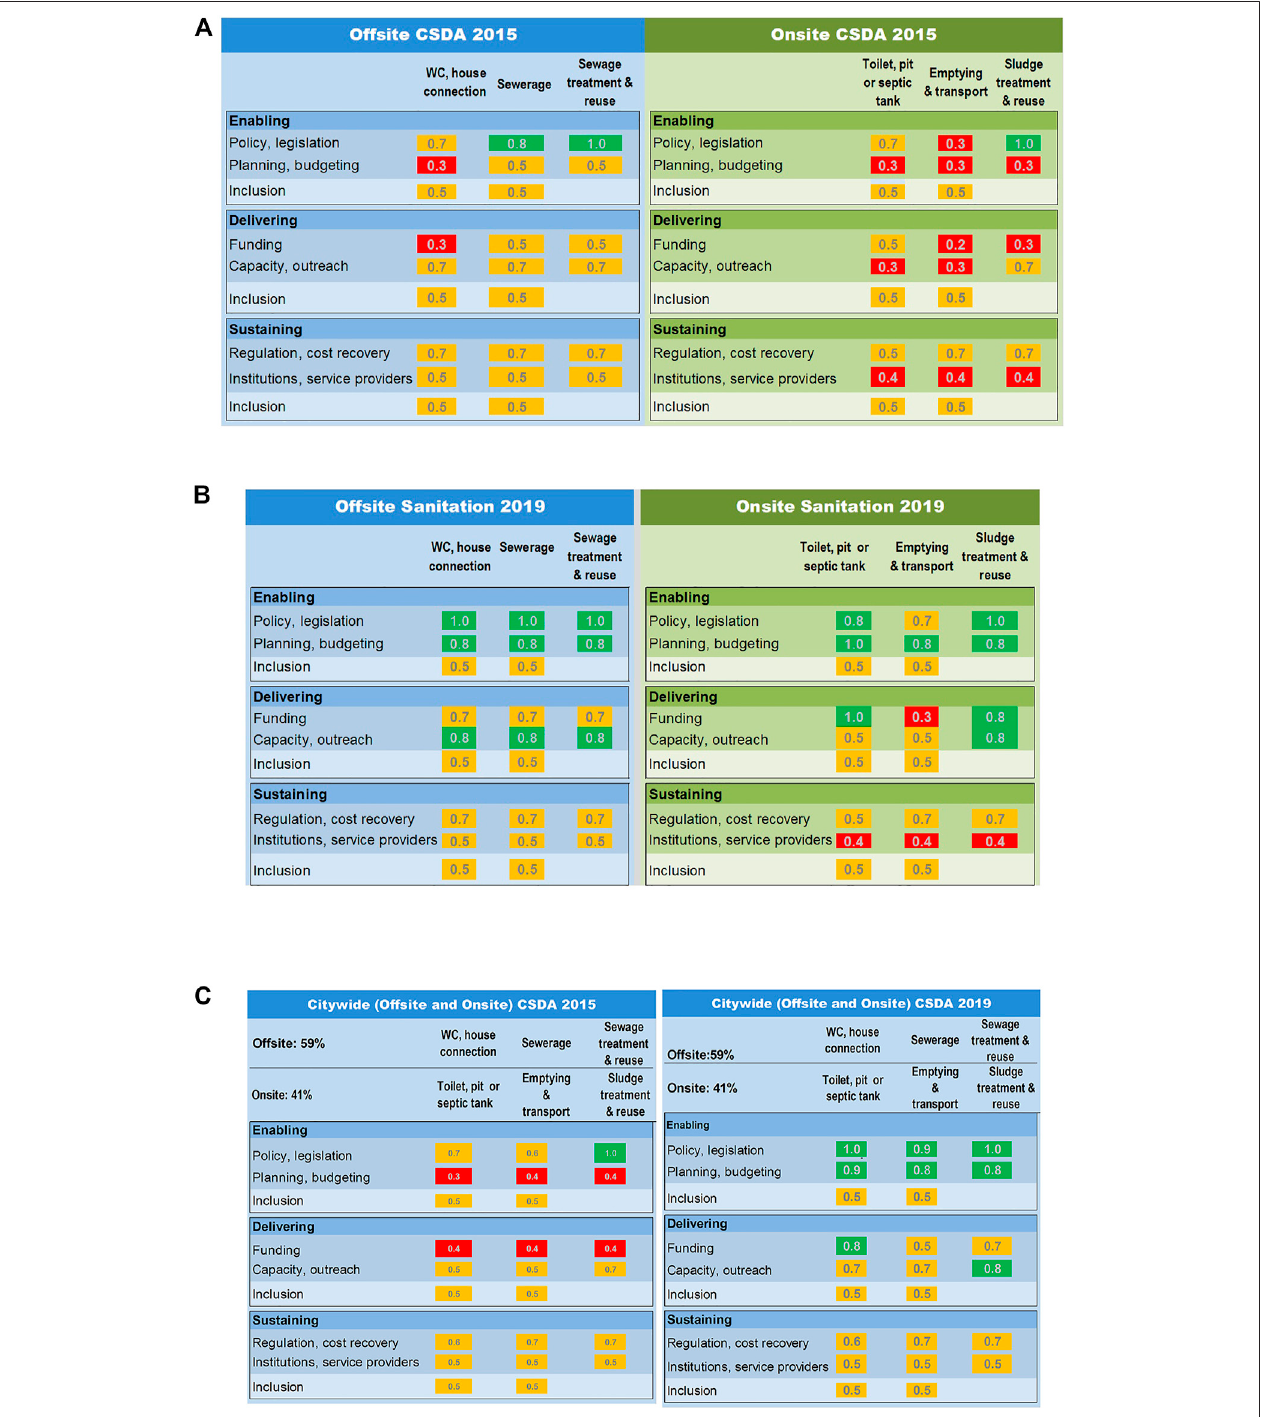
FIGURE3|(A) CityServiceDeliveryAssessments(CSDAs)forTrichy,offsite(blue)andonsite(green)sanitation2015, (B) offsite(blue)andonsite(green)2019,and (C) citywide 2015 and 2019.